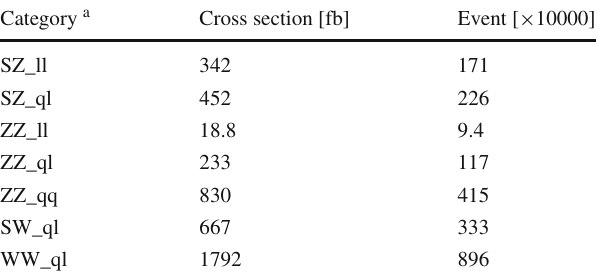
Table 1 The cross sections and event numbers of the four fermion processes belonging to different categories at the 240 GeV CEPC with an integrated luminosity of 5 ab − 1 . See text for